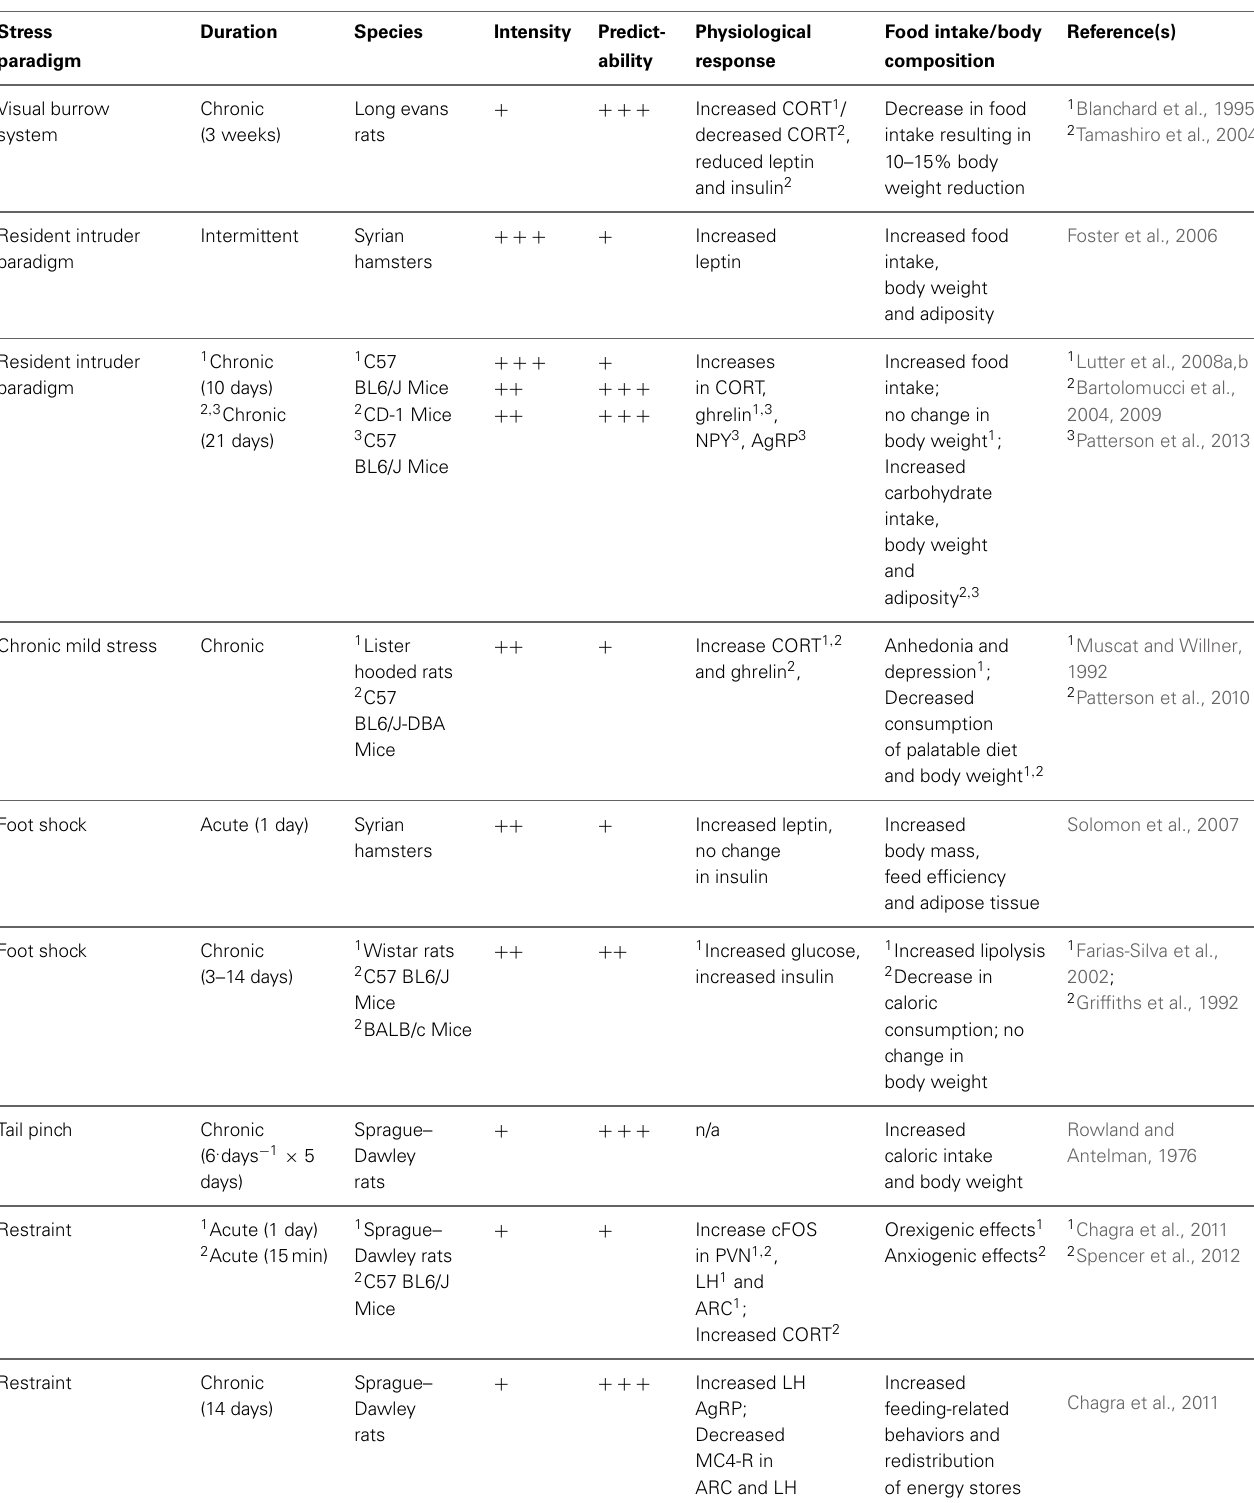
Table 1 | Summary of stress paradigms, hormonal responses and physiological